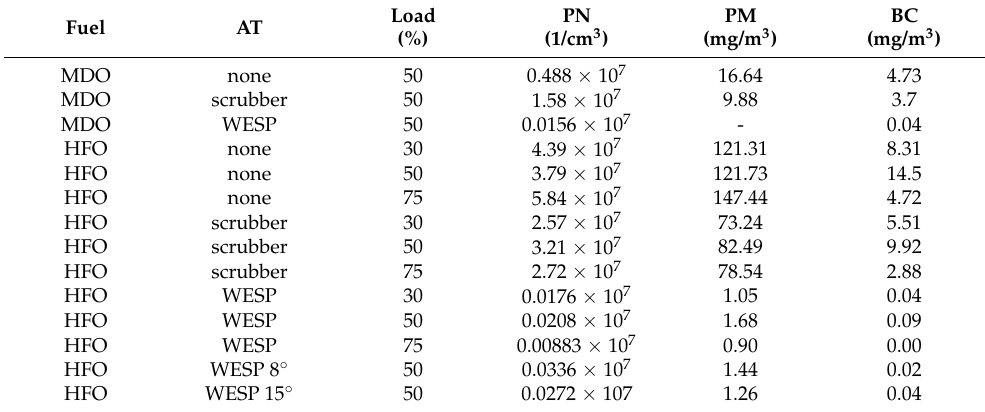
Table A1. Particle concentrations in the measurements for different fuels and aftertreatments (AT).